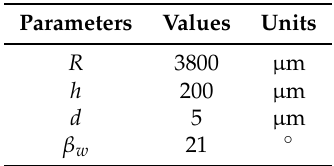
Table 3. Parameters of the MHR.